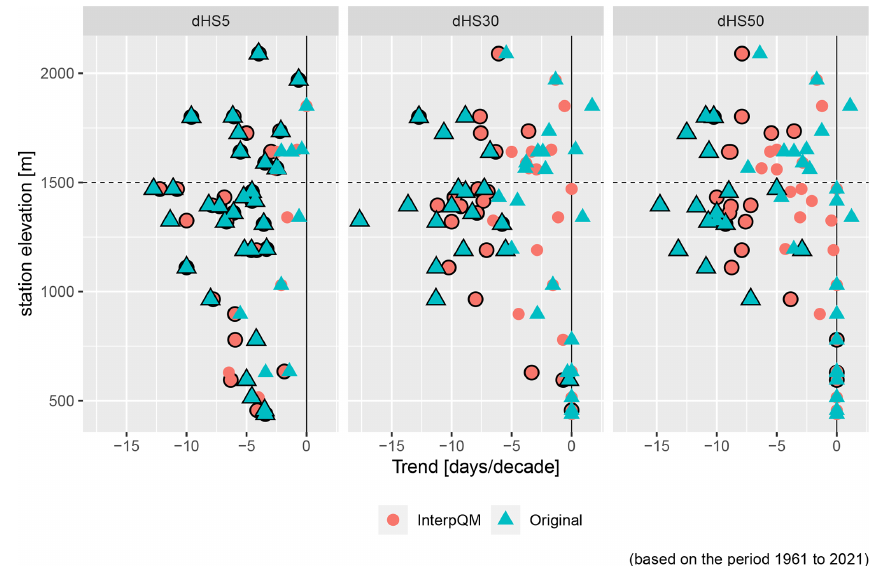
Figure A1. Absolute trends for days with snow depths of at least 5, 30 and 50cm per season. Significant trends are marked by a black border.